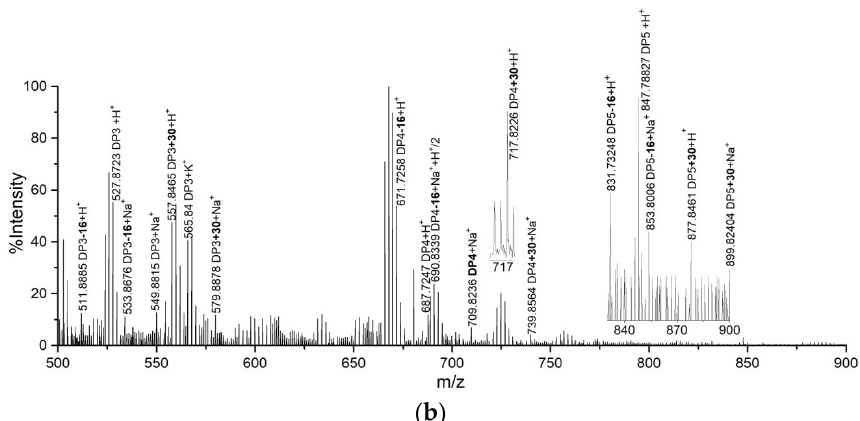
Figure 5. Identification of n Ta AA9A permethylated reaction products with xylan as a substrate using TLC and MALDI–TOF MS. ( a ) TLC: n Ta AA9A reaction products upon incubation of 0.5% xylan with Ta AA9A in 10 mM HOAc–NH 4 OAc (pH 5.0) and 1 mM ascorbate at 50 °C for 48 h. Lane M, standard cello-oligosaccharides (G1–G6); Lane S, n Ta AA9A reaction products; Lane CK, control sample analyzed as above but without n Ta AA9A. ( b ) MALDI–TOF MS: n Ta AA9A reaction products after incubation of 0.5% xylan with n Ta AA9A in 10 mM HOAc–NH 4 OAc (pH 5.0) and 1 mM ascorbate at 50 °C for 48 h, followed by permethylation with methyl iodide. C1-oxidized xylo-oligosaccharides ( m / z +30), C4-oxidized xylo-oligosaccharides ( m / z − 16), and non-oxidized xylo-oligosaccharides ( m / z +0).